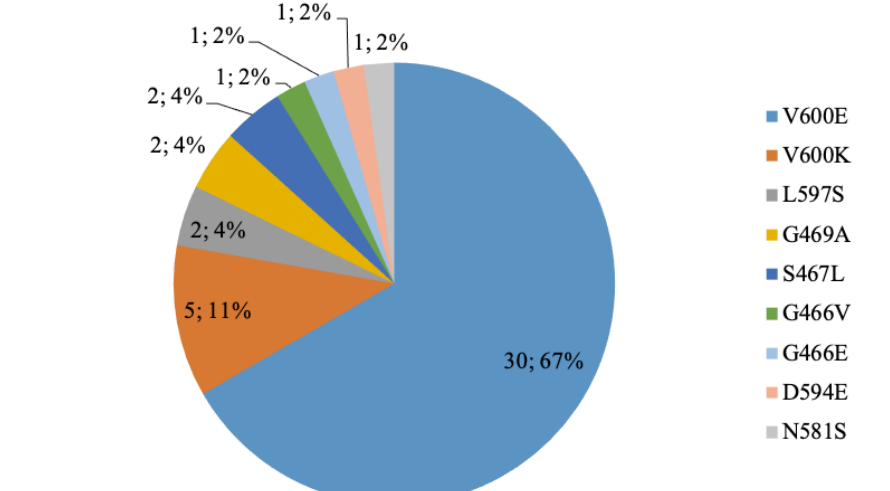
Figure 5. Schematic representation of the distribution of the different BRAF mutations ( N = 45) identified in 115 samples from advanced melanomas by